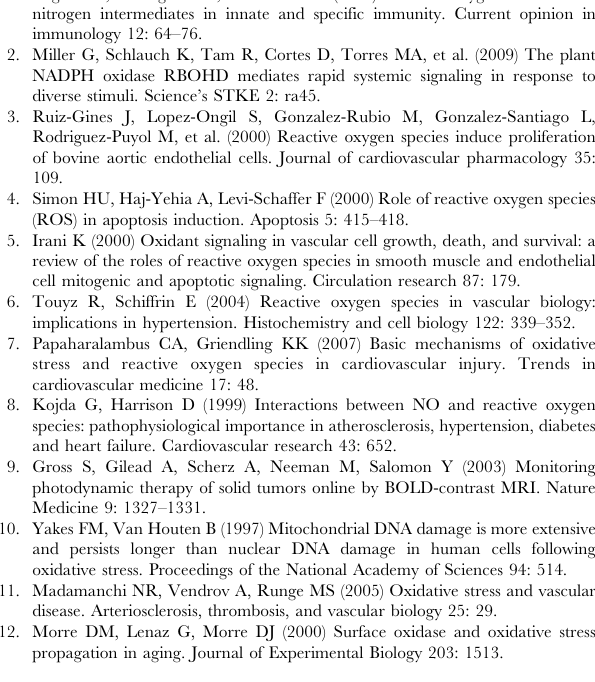
Table S1 Fluorescent probes used and their application